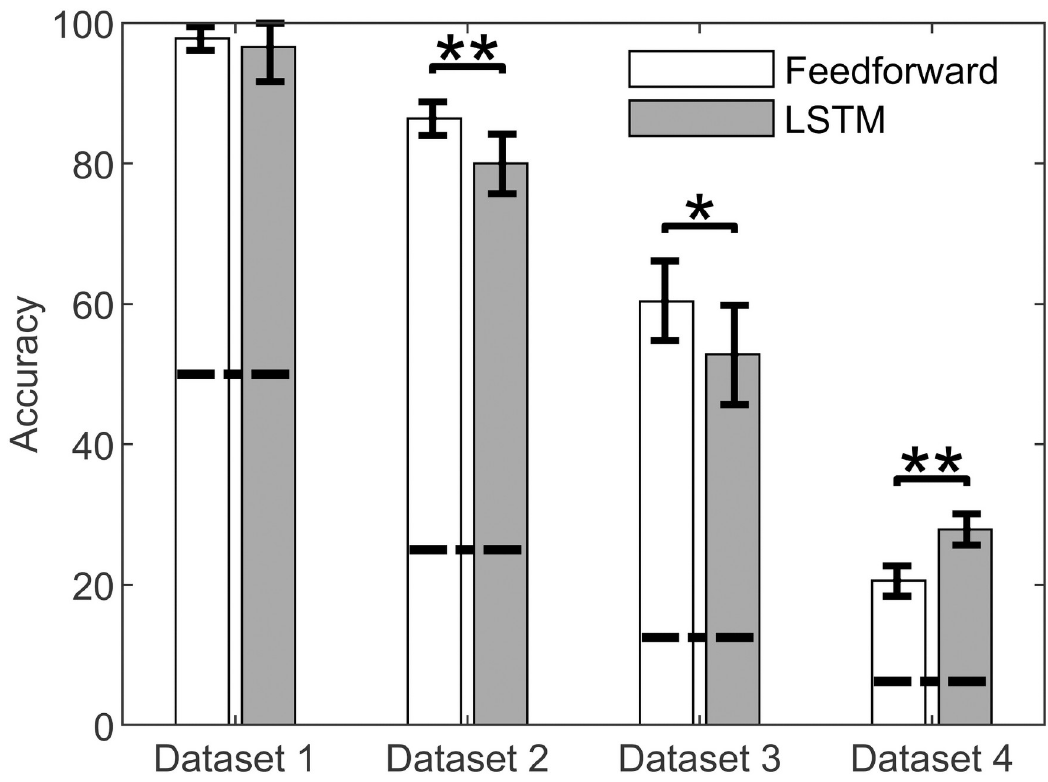
Fig 5. Accuracy of each artificial neural network. Average peak test accuracies achieved by both neural network models through 5-fold cross-validation. Error bars represent 95% confidence intervals and horizontal dashed lines represent the model’s accuracy for a random guess. Two-sample t-tests showed significant differences between accuracies across FF and LSTM models ( � corresponds to significance p < 0.05, �� corresponds to significance p < 0.01).